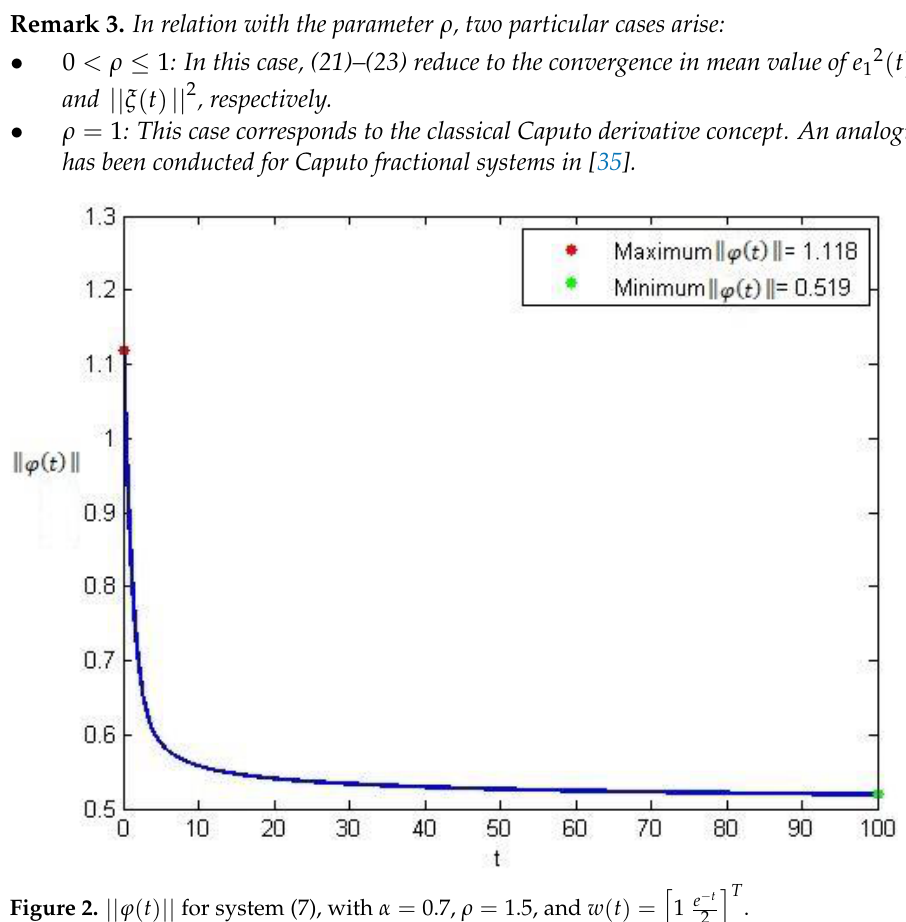
Figure 2. ‖𝜑(𝑡)‖ for system (7), with 𝛼 = 0.7 , 𝜌 = 1.5, and 𝑤(𝑡) = [1 𝑒